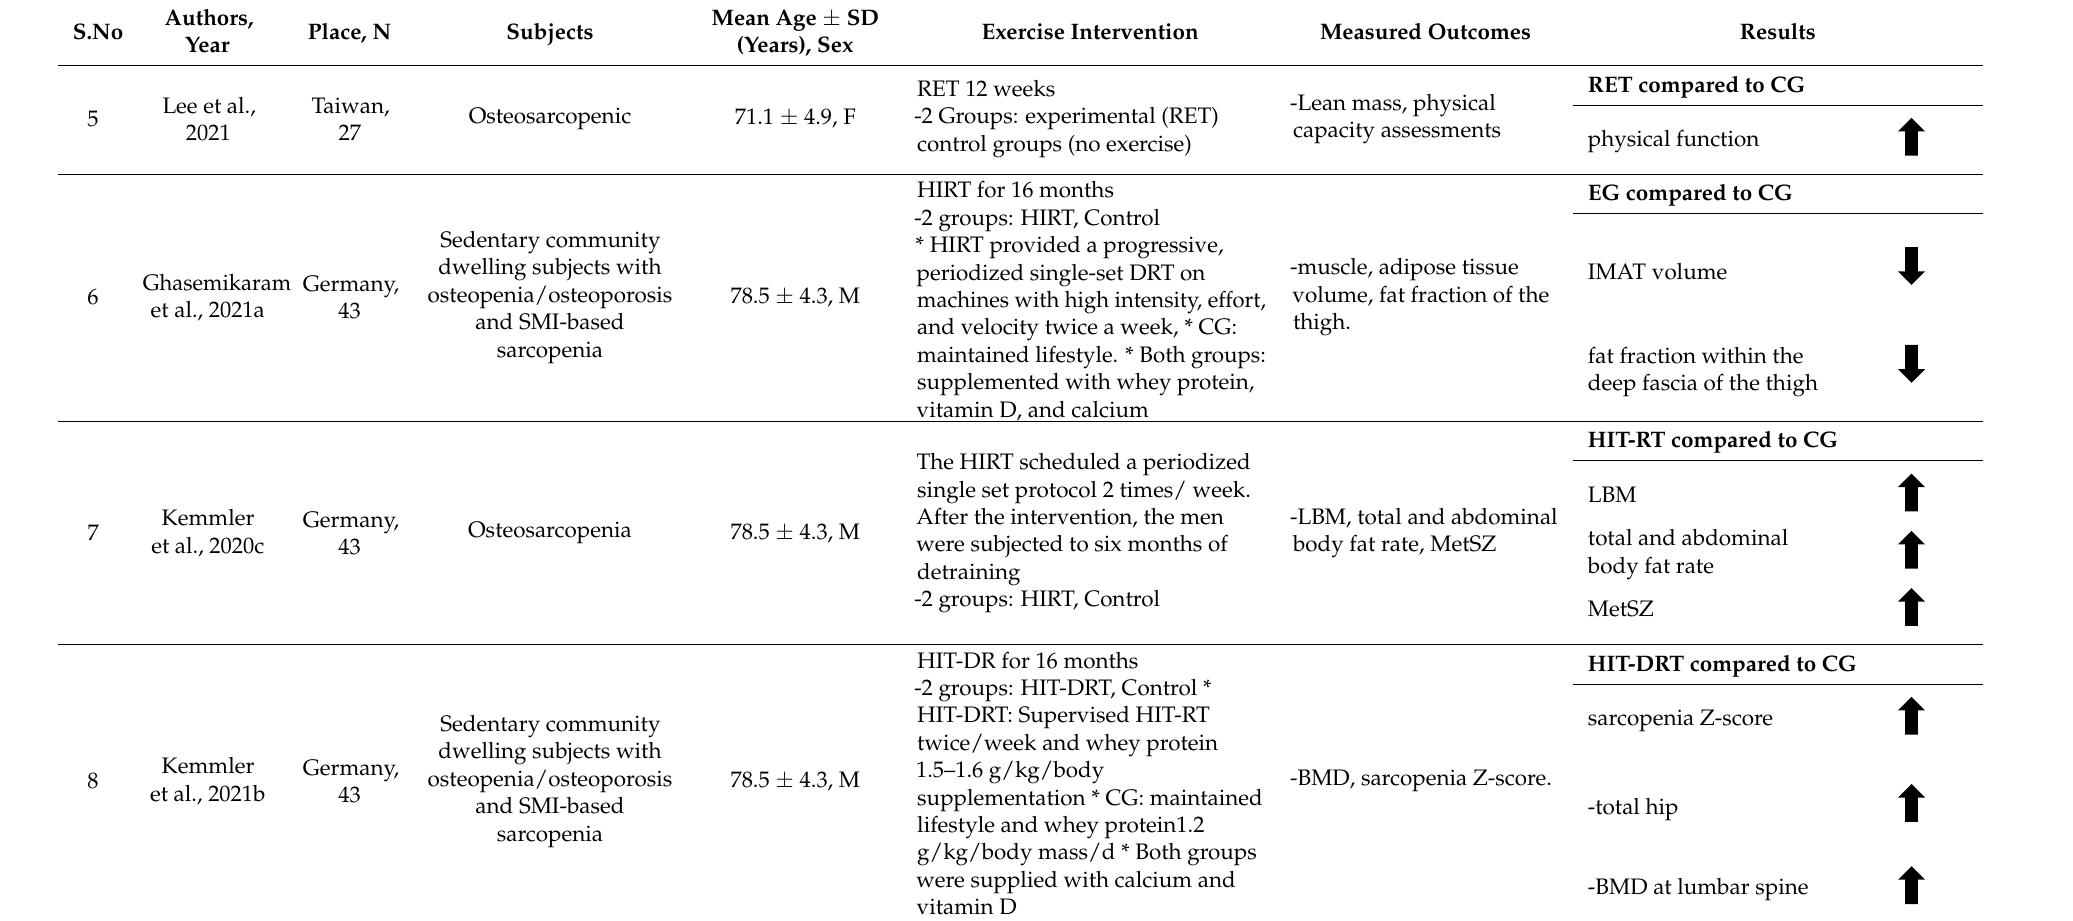
Table 2. Cont. Table 1. Effect of exercise on subjects with cancer and baseline measurement of sarcopenia.